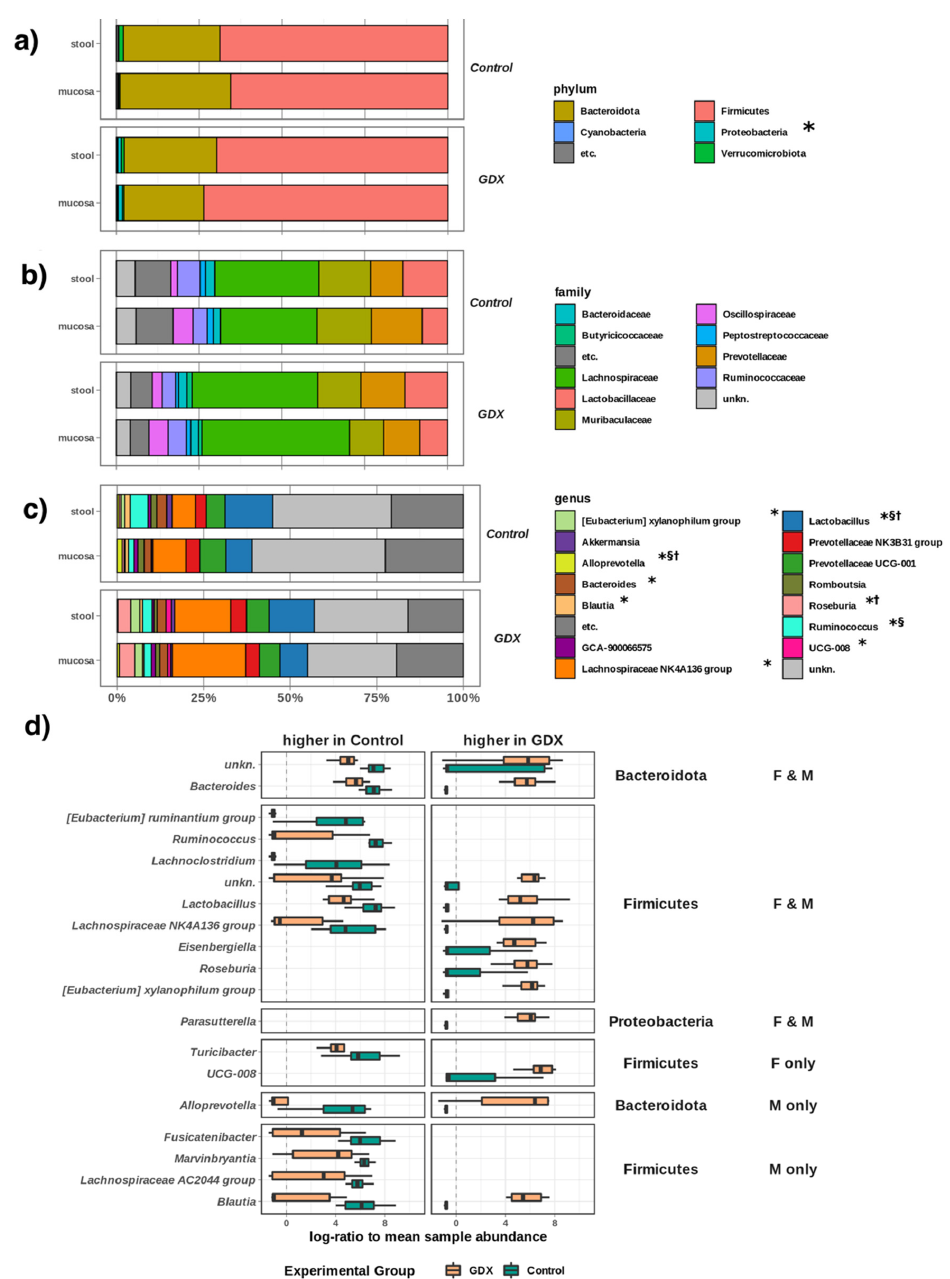
Figure 5. Microbial composition and taxa significantly affected gonadectomy: ( a ): Phylum level; ( b ): Family level; ( c ): Genus level; ( d ): Summary of genera which differ significantly across the study (FDR < 0.05), whether in both females (F) and males (M), F only, or M only. Some genera (e.g., Bacteroides , Alloprevotella ) appear higher in both the control and GDX rats as there are multiple distinct members (e.g., species) within that genus, which show different responses to sex and GDX. a–c: all taxa > 3.5% abundance, in 10% of samples (remainder grouped to “etc.”). “*” indicates taxa differentially abundant between experimental groups (GDX, control); “†” indicates taxa differentially abundant between substrates (mucosa, stool); “§” indicates differentially abundant taxa between sexes (male, female).